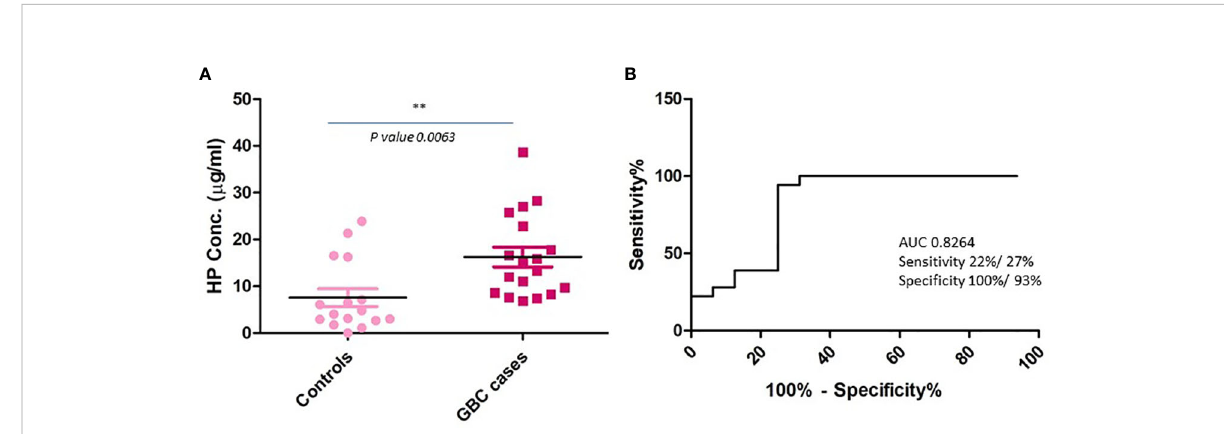
FIGURE 5 Plasma level of HP in GBC cases and controls using quantitative ELISA. (A) Scatter plot showing concentration in plasma samples. Controls include healthy individuals and GSD cases. A signi fi cant increase in the levels of HP was observed in GBC cases (B) ROC curve representing sensitivity and speci fi city for HP. ** p value is less than or equal to